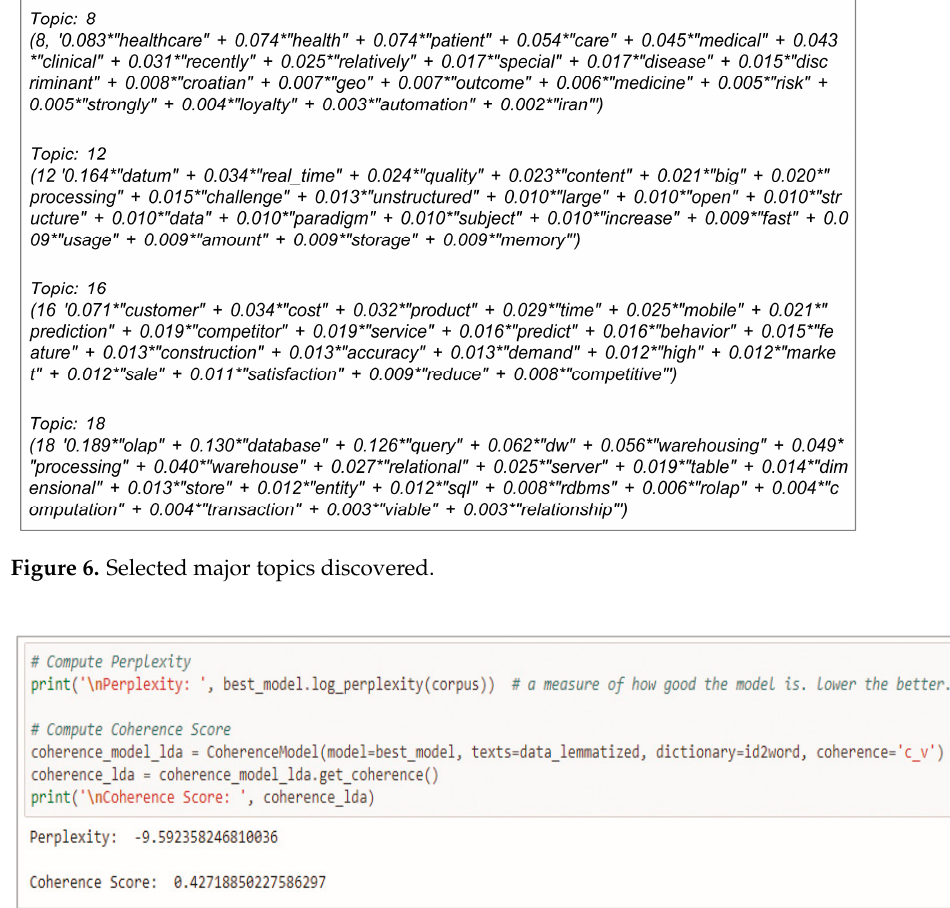
Figure 7. Code 4: metrics perplexity and coherence, own elaboration.